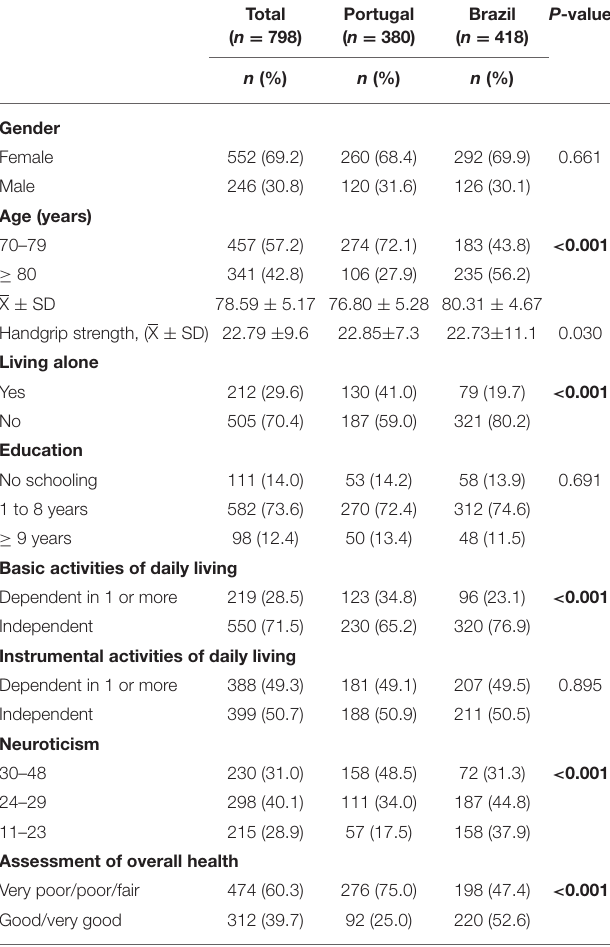
TABLE 1 | Sample characteristics according to country ( n = 798). TABLE 2 | Comparison of samples from Brazil and from Portugal regarding